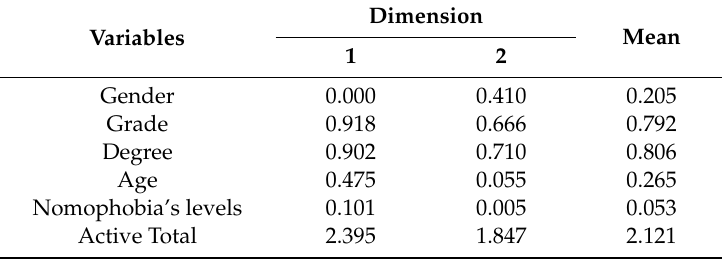
Table 7. Discrimination measures of the variables.